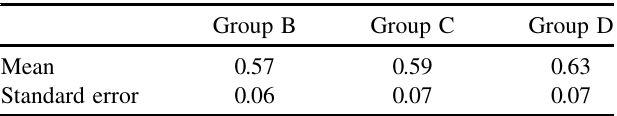
TABLE VI. Average physics grades (normalized to 1) for self- diagnosis of the pre (quiz 7) solutions.